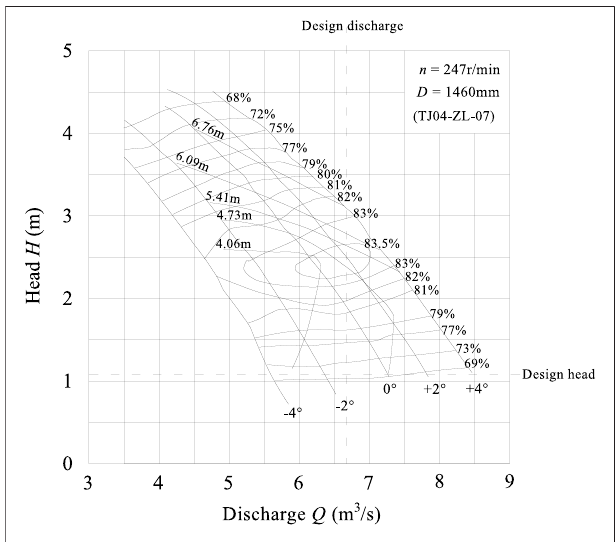
FIGURE 1 | Comprehensive performance curve of the pump